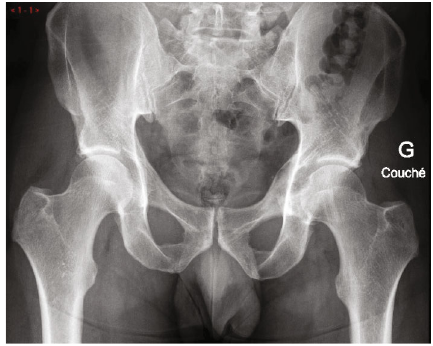
Figure 11: AP pelvic plain fi lm showing a lytic lesion of the left iliopubic